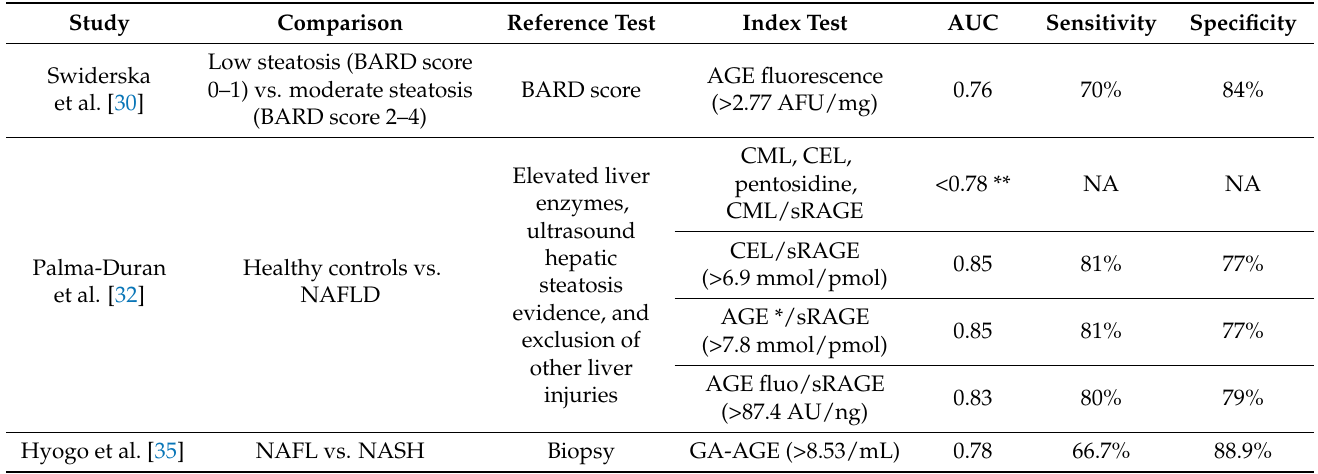
Table 2. Diagnostic accuracy of